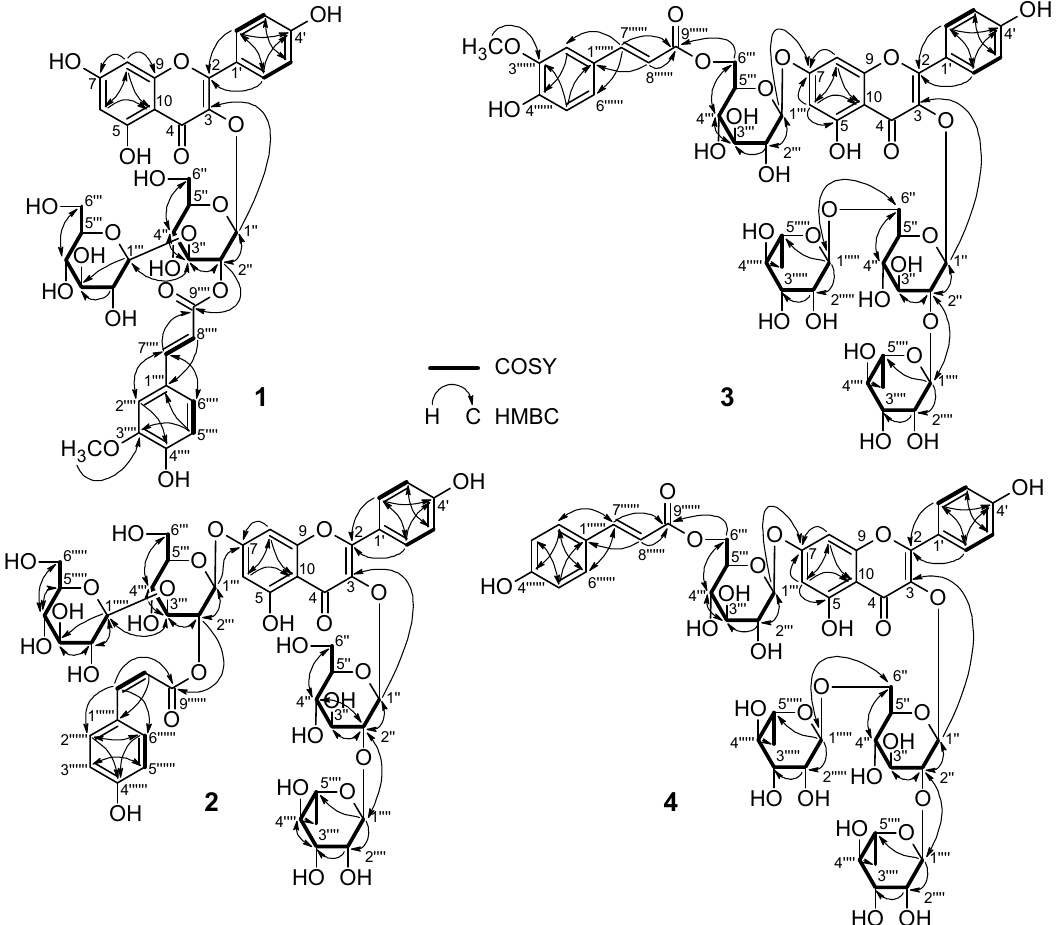
Figure 2. COSY and HMBC correlations of 1 – 4 .